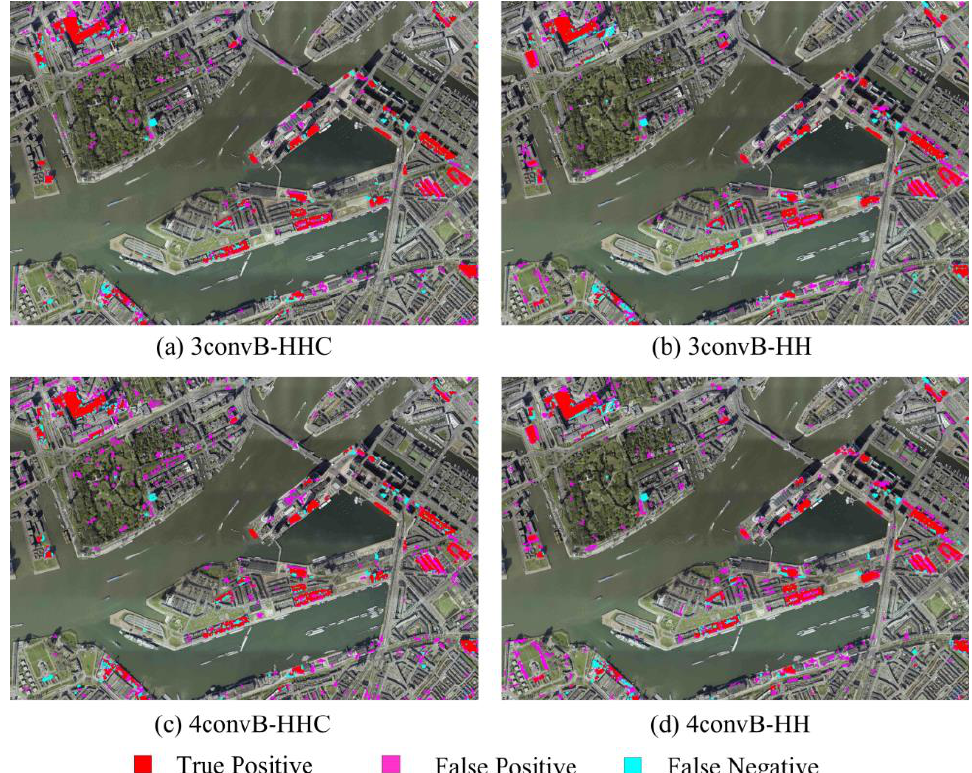
Figure 7. Change maps from four CNN architectures (T 3 = 20 m): 3convB-HHC, 3convB-HH, 4convB-HHC,